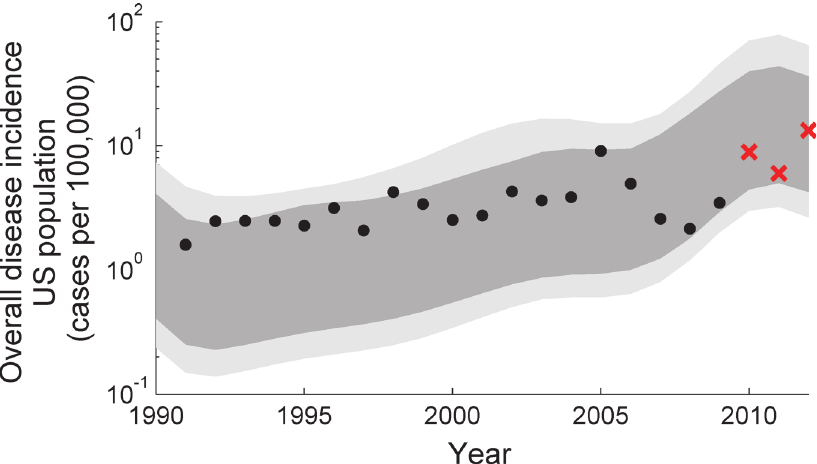
Fig 2. Incidence of disease in the United States, compared with modeled values. The time varying incidence of disease cases in the model and the US data (log scale) after 1990. The black dots are US disease incidence data, and the shaded regions represent the credible intervals (50% and 95%) obtained through model parameter estimation of model 8. The model has been run beyond the time over which it was trained to illustrate its continued correspondence with the 2010 – 2012 data (red